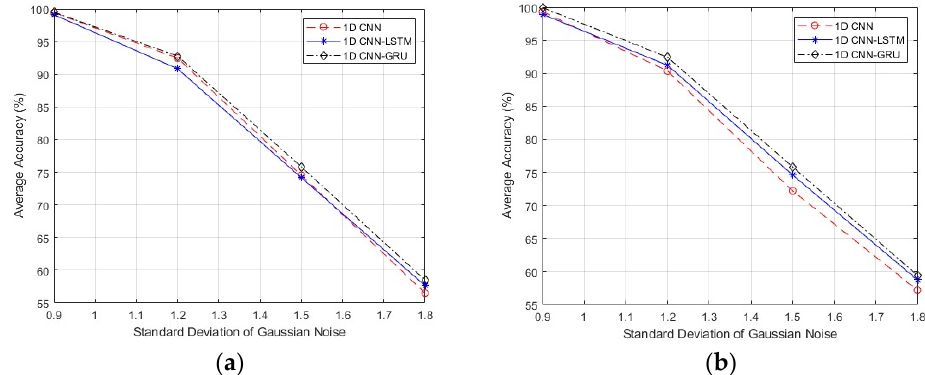
Figure 7. The average accuracy according to the standard deviation of Gaussian noise in the optimized networks: ( a ) using this paper’s dataset; ( b ) using a new dataset.